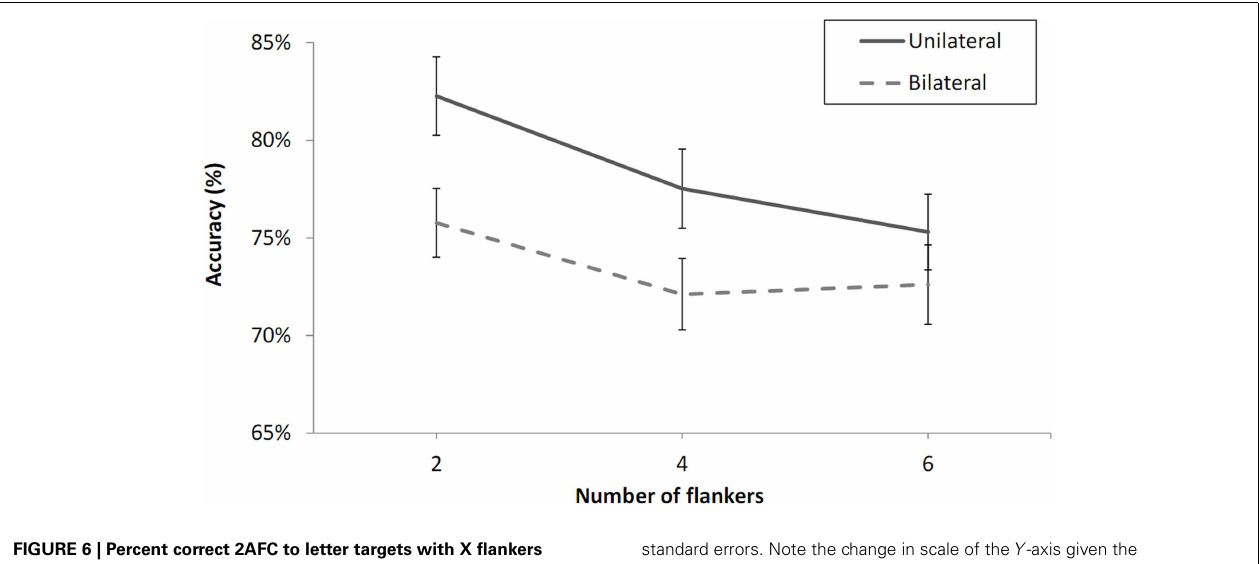
FIGURE 6 | Percent correct 2AFC to letter targets with X flankers under unilateral and bilateral presentation conditions as a function of the number of flankers in Experiment 2. Error bars are